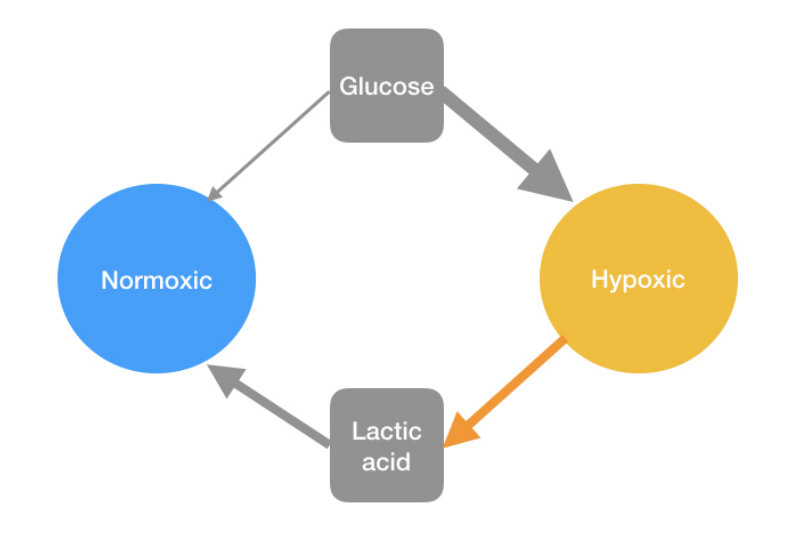
Figure 13. Interaction diagram between different type of cells. The hypoxic cells can benefit from the presence of oxygenated non-glycolytic cells with modest glucose requirements, whereas cells with aerobic metabolism can benefit from the lactic acids that are the byproduct of anaerobic